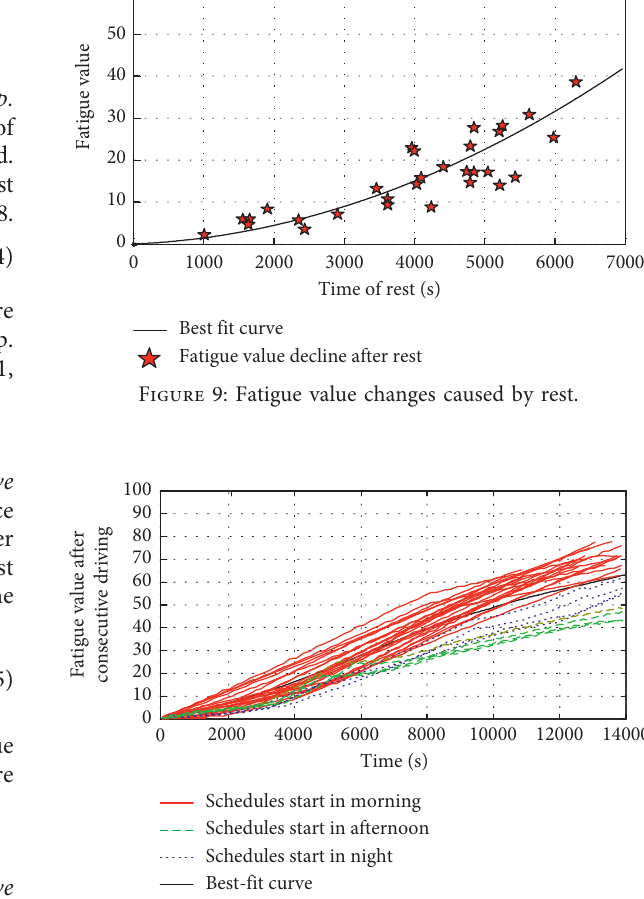
Figure 10: Fatigue value changes after consecutive